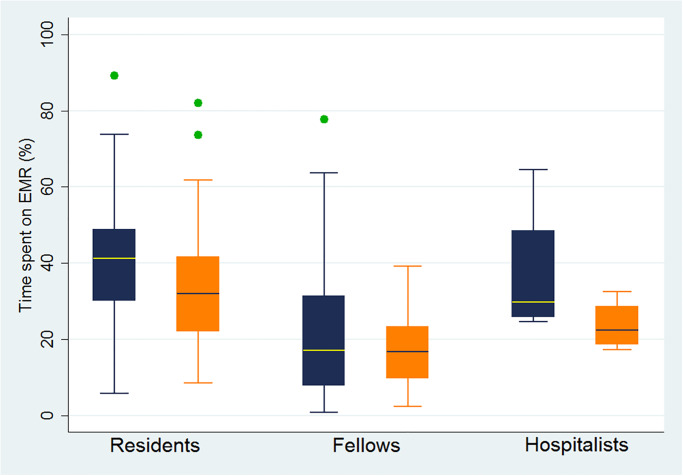
Time spent on EMR daily (%) and clinician training.Blue—First academic quarter; Orange—Fourth academic quarter.